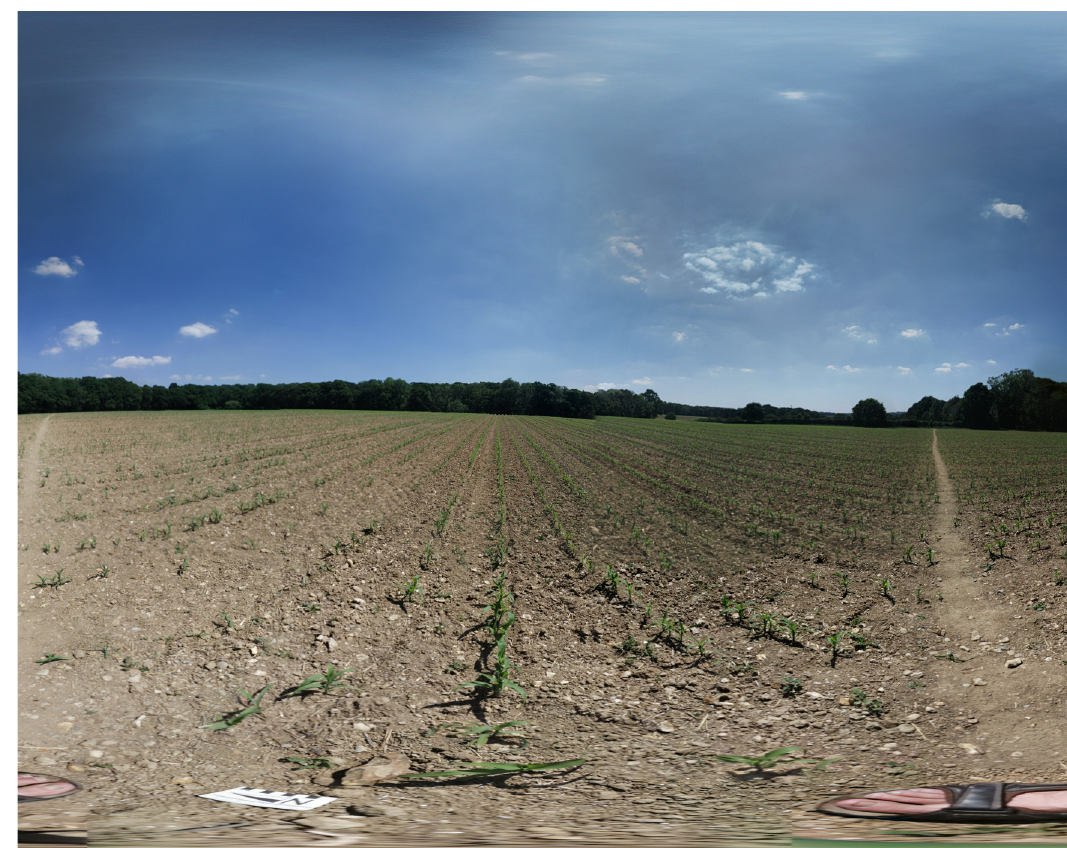
Figure 2: Unwrapped 360° panoramic photo of a fl int tool encounter in a Hampshire fi